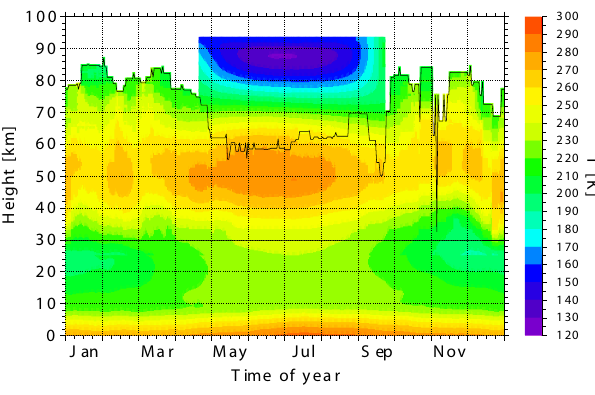
Fig. 5. Standard deviations of the single night-mean temperature profiles calculated for 15-day intervals. This gives an impression of the geophysical variability of the atmosphere above ALOMAR.